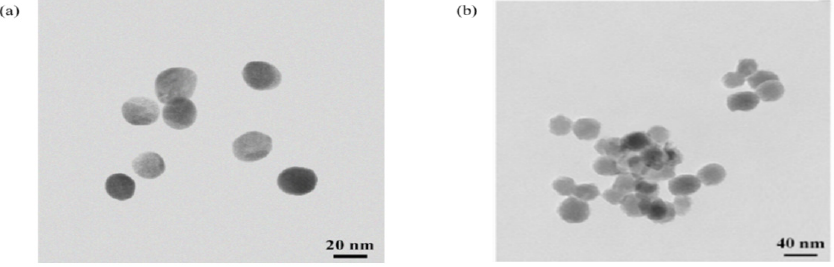
Figure 2. Transmission electron microscopy (TEM) images of the gold nanoparticles with a diameter of approximately 20 nm ( a ) and 40 nm ( b ).